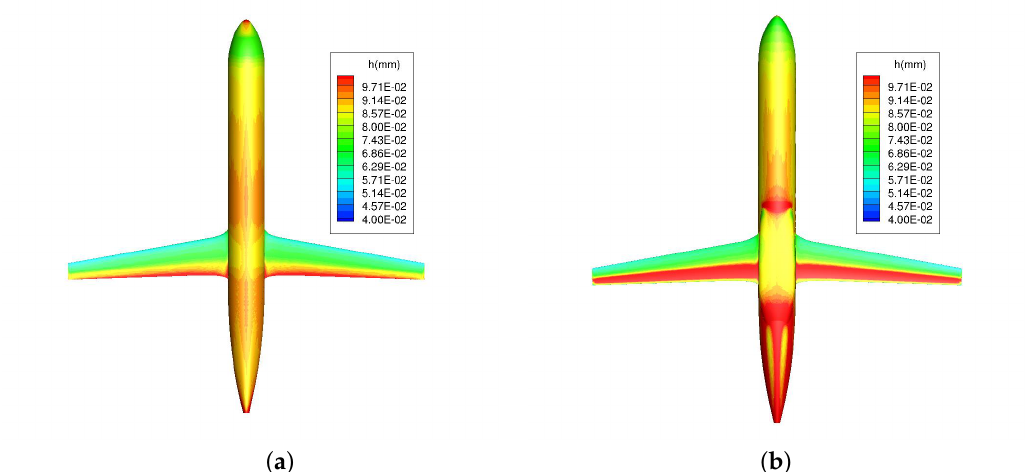
Figure 14. NLF wing body: Re ∞ = 18.2 × 10 6 , M ∞ = 0.64, C L = 0.5. Computed optimal riblet height distribution (symmetric sawtooth riblets). ( a ) Upper skin, ( b ) lower skin